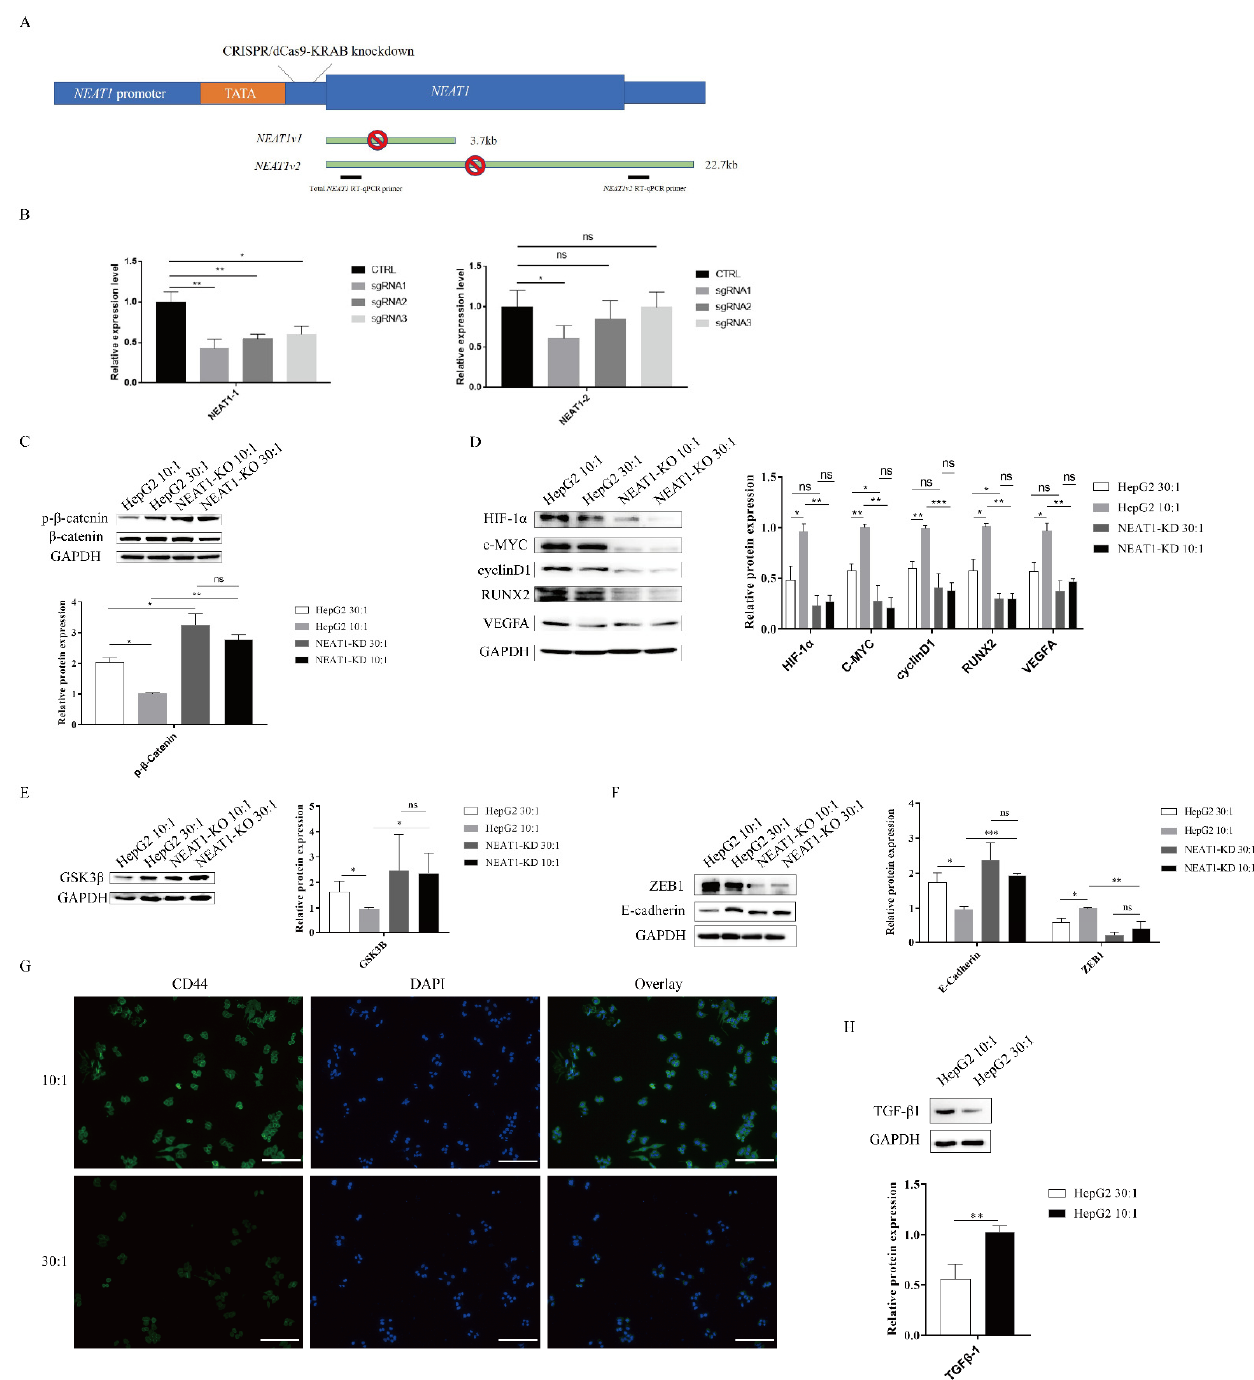
Figure 4. The lncRNA NEAT1 activates the WNT/ β -catenin pathway in response to matrix stiffness stimuli. ( A , B ) Gener- ation of HepG2 cell lines lacking expression of NEAT1 by CRISPR/dCas9-KRAB. ( A ) A schematic representation of the total NEAT1 knockdown strategy through CRISPR/dCas9-KRAB-mediated knockdown. A dCas9-KRAB guided by either NEAT1 promoter-targeting sgRNA was introduced to the region between the TATA box and the transcription start site (TSS) of NEAT1 . ( B ) NEAT1 knockdown efficiency was detected by the two RT-qPCR primers (black bars). ( C – E ) Effect of substrate stiffness on the expression of β -catenin in HepG2-KD and HepG2 cells. ( C ) HepG2 cells were cultured in 3D micropillars (10:1, 30:1) for 24 h. Western blot analyzed the protein expressions of β -catenin and p- β -catenin. ( D ) Effects of substrate stiffness on the expression of the downstream protein of Wnt/ β -Catenin in HepG2-KD and HepG2 cells. HepG2 cells were cultured in 3D micropillars (10:1, 30:1) for 24 h. Western blot analysis of protein expressions. ( E ) Effects